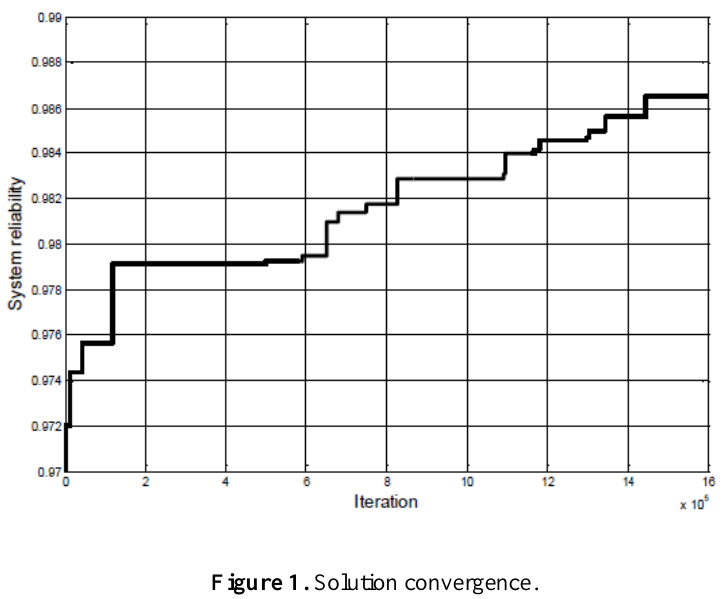
Figure 1. Solution